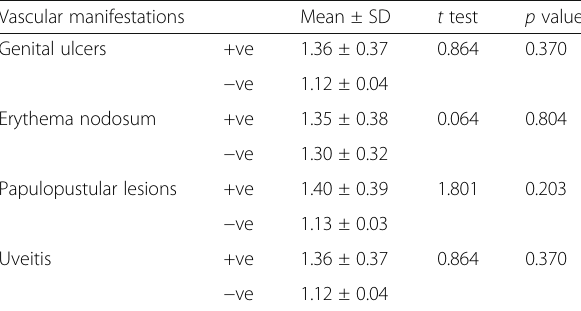
Table 4 Endocan levels in patients regarding vascular manifestations of BD patients Vascular